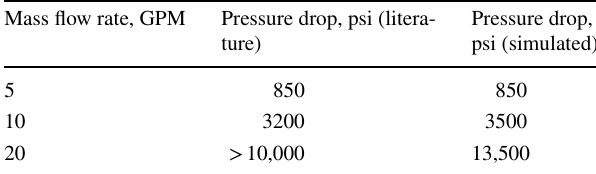
Table 4 Comparison of simulated pressure drop values with